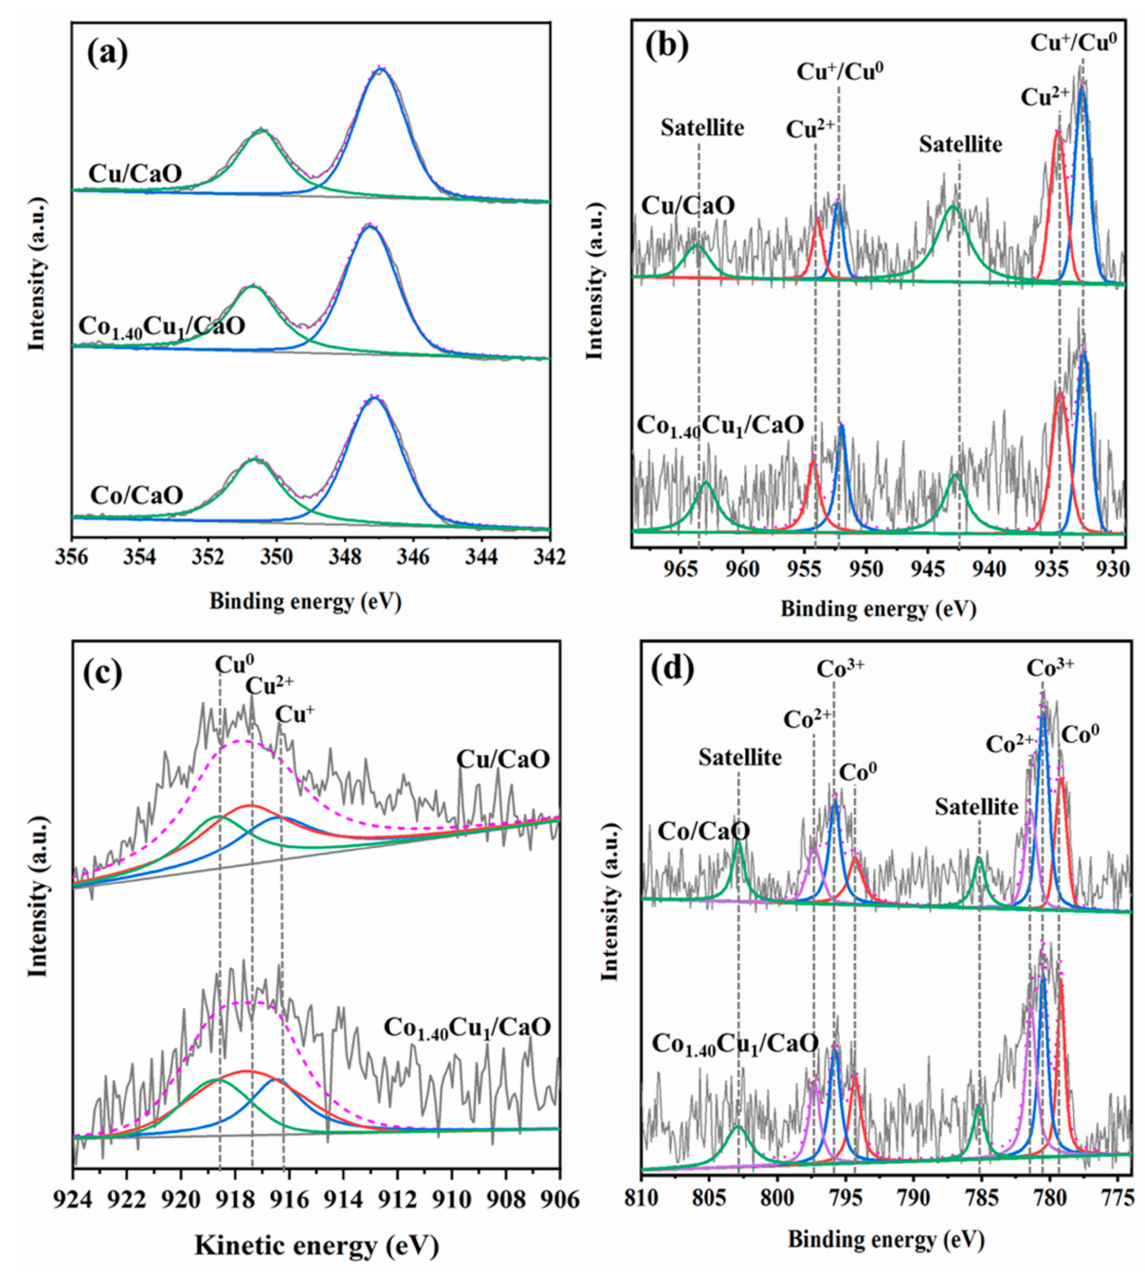
Figure 3. XPS spectra of ( a ) Ca 2p of reduced Cu/CaO, Co 1.40 Cu 1 /CaO, and Co/CaO catalysts, ( b ) Cu 2p of reduced Cu/CaO and Co 1.40 Cu 1 /CaO catalysts, ( c ) Cu LMM of reduced Cu/CaO and Co 1.40 Cu 1 /CaO catalysts, and ( d ) Co 2p of reduced Co/CaO and Co 1.40 Cu 1 /CaO